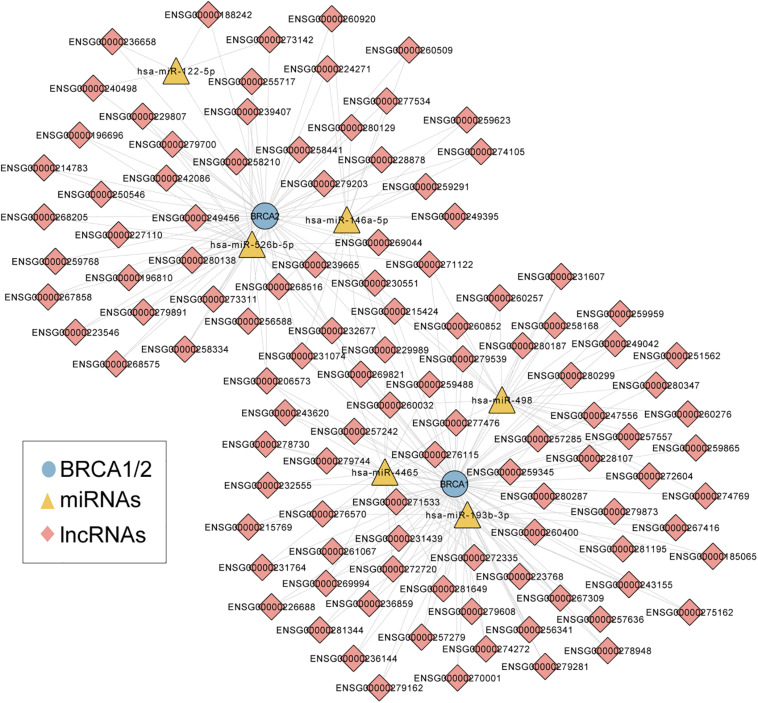
A global view of BRCA1/2-directed ceRNA networks comprised of 119 nodes (including BRCA1/2, 111 lncRNAs, and six miRNAs) and 250 edges.